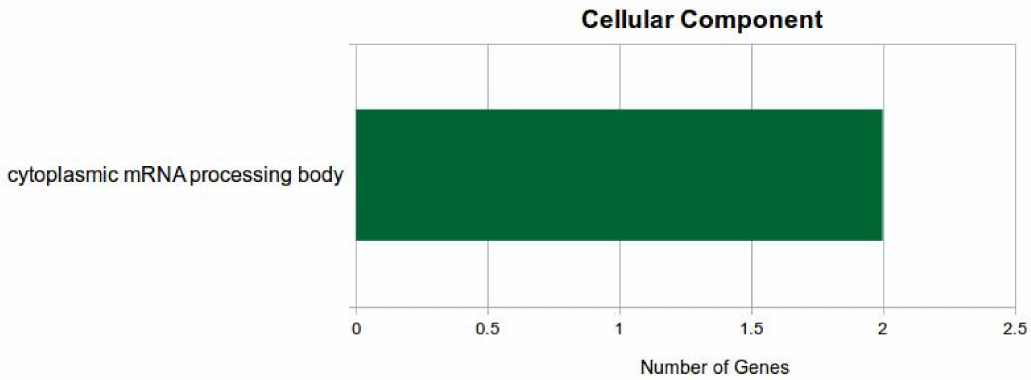
Figure 5. Number of differentially expressed miRNA genes in cytoplasmic mRNA processing